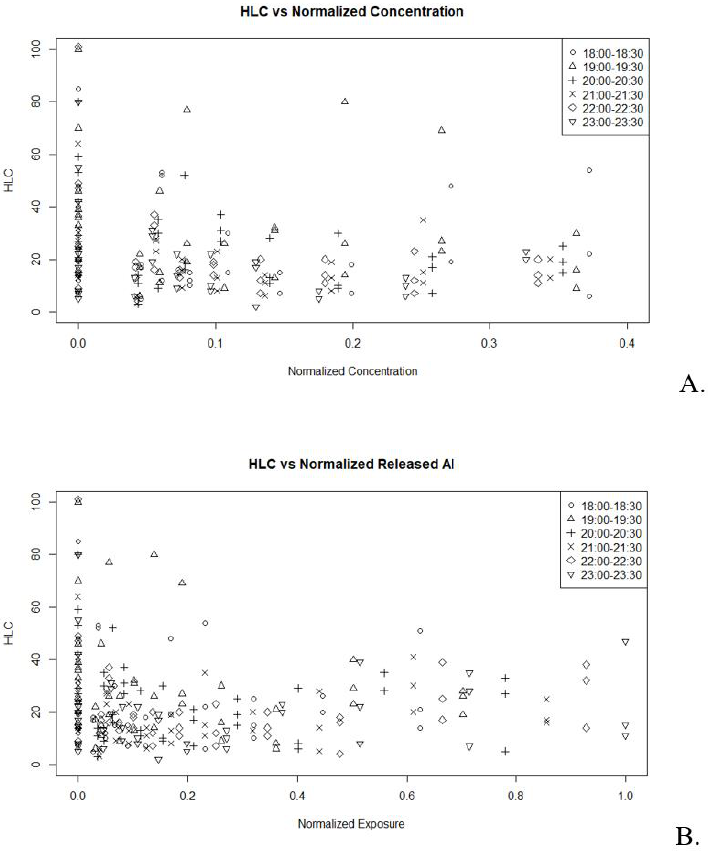
Figure B3. Simulated concentration and mass released. ( A ) HLC vs. normalized concentration. ( B ) HLC vs. normalized released AI.